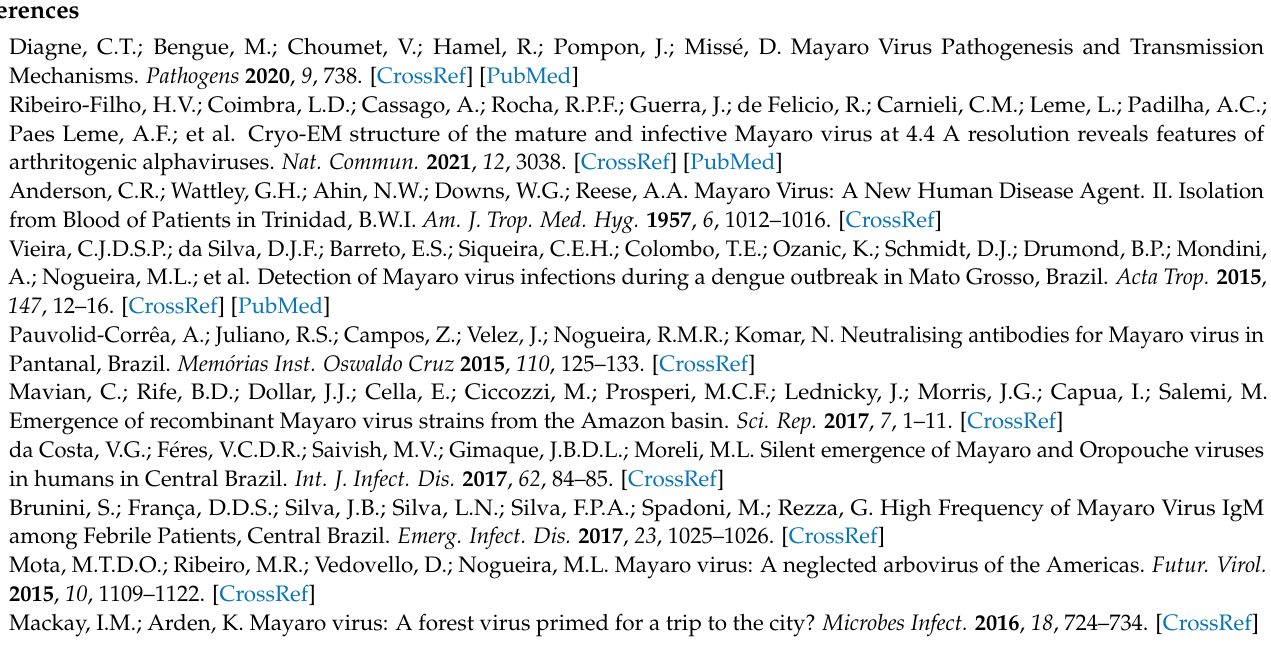
metabolites concentrations at 2 hpi.; Figure S4: Boxplots indicating metabolites concentrations at 6 hpi.; Figure S5: Boxplots indicating metabolites concentrations at 12 hpi.; Figure S6: Loadings from PCA and PLS-DA for each time point. Metabolites with high values are Acetate, Glucose, Pyruvate, Glutamine, Ethanol, and Lactate for all time points. The bottom shows the PLS-DA performance in leave-one-out cross-validation for each time post-infection; Figure S7: SVM classification of MAYV infected cells at 2 hpi. Assessment of model quality through classification using SVM with its built-in variable selection approach and evaluation by means of area under the ROC curves. Classification performance is related to the robustness of the metabolites identified in the chemometric analysis in predicting a metabolic profile in control or infected cell; Figure S8: SVM classification of MAYV infected cells at 6 hpi. Assessment of model quality through classification using SVM with its built-in variable selection approach and evaluation by means of area under the ROC curves. Classification performance is related to the robustness of the metabolites identified in the chemometric analysis in predicting a metabolic profile in control or infected cell.; Figure S9: SVM classification of MAYV infected cells at 12 hpi. Assessment of model quality through classification using SVM with its built-in variable selection approach and evaluation by means of area under the ROC curves. Classification performance is related to the robustness of the metabolites identified in the chemometric analysis in predicting a metabolic profile in control or infected